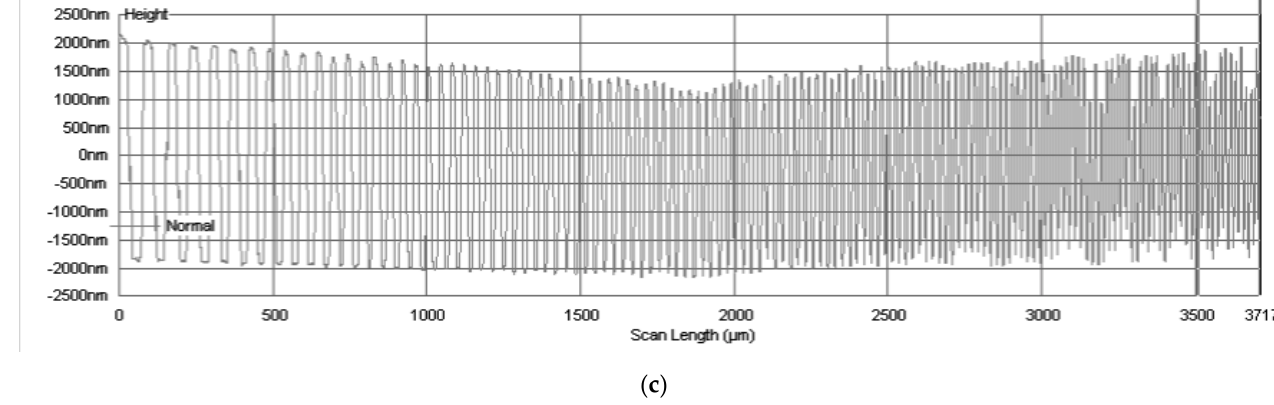
Figure 1. An optical microscope image of ( a ) an SDL (455 nm, 750 nm), ( b ) an SDL fragment with fine structure (455 nm, 750 nm), and ( c ) a profilogram of the SDL (455 nm, 750 nm) measured relative to the lens symmetry axis using a Tencor profiler.